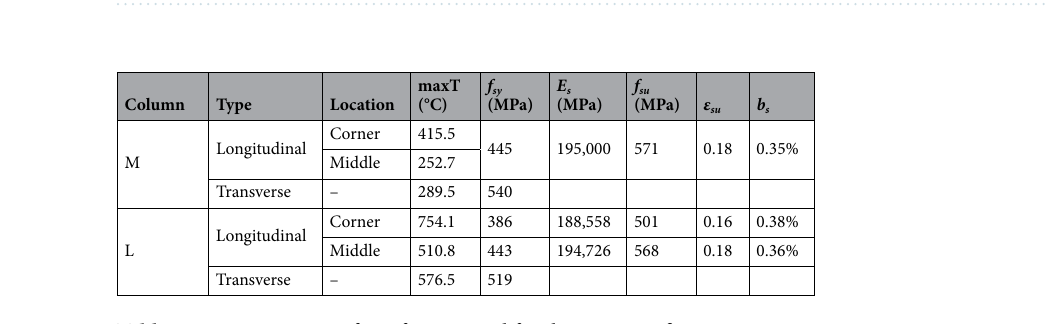
Table 2. Maximum temperature experienced by the element closest to the longitudinal bars as well as each ring in the cover and core.